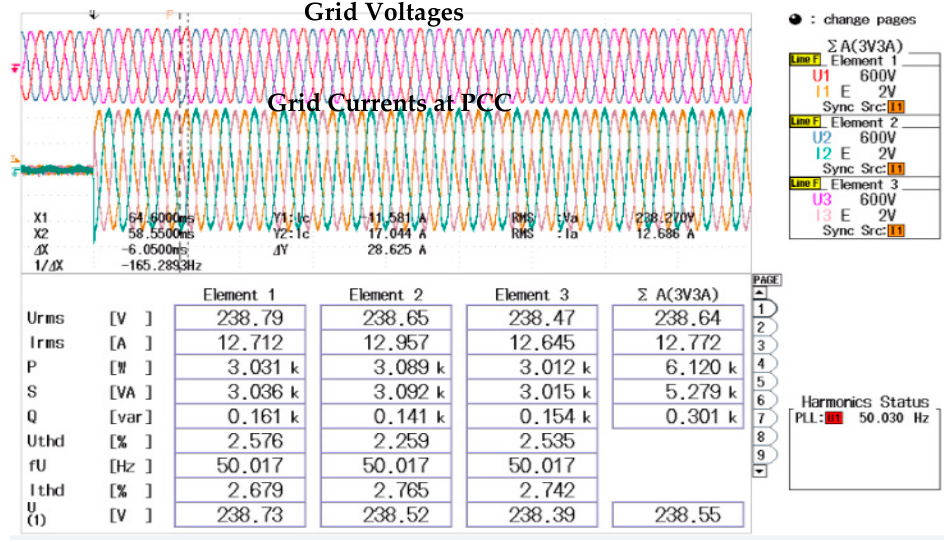
Figure 18. Experimental results captured from the oscilloscope.